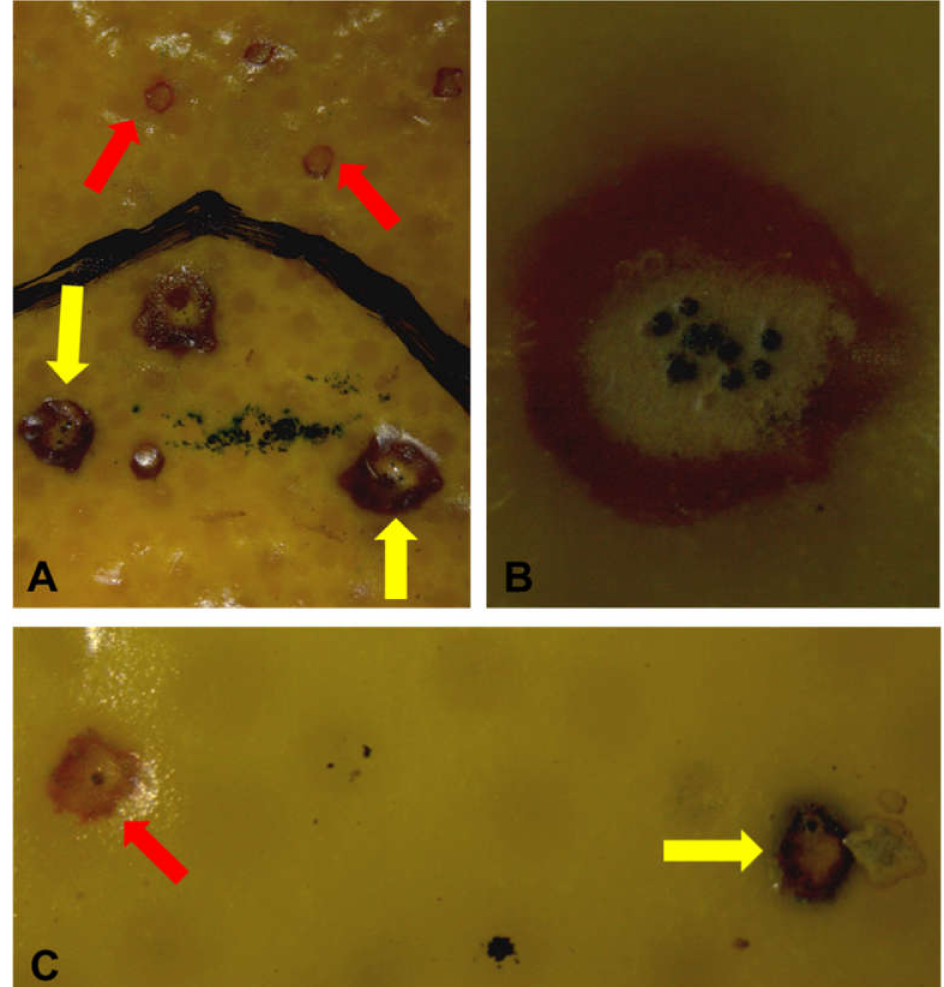
Figure 1. Citrus black spot (CBS) lesions on fruit. ( A ) Newly developed and old CBS lesions on a ‘Midknight’ Valencia orange fruit subjected to a complete packhouse treatment regime consisting of pre-packhouse drench, chlorine wash, fungicide dips and wax application. ( B ) New CBS lesion with pycnidia on untreated ‘Eureka’ lemon fruit. ( C ) New and old CBS lesions on untreated ‘Eureka’ lemon fruit. New and old CBS lesions are shown by red and yellow arrows,